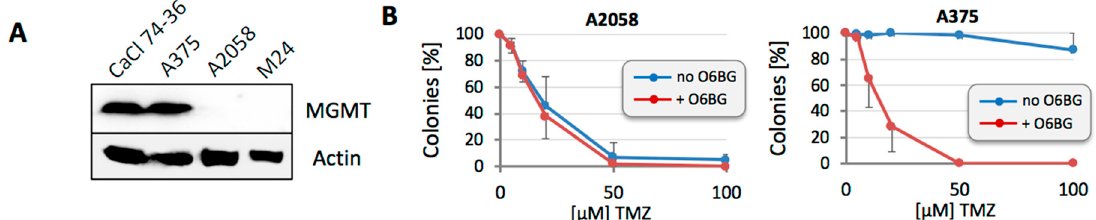
Figure 1. MGMT (O6-methylguanine-DNA methyltransferase) levels and protection from TMZ (temozolomide) toxicity. ( A ) Protein lysates were prepared from four different melanoma cell lines and MGMT protein levels were analyzed by Western blot. Actin was used as the loading control. ( B ) MGMT-negative 2058 cells and MGMT-positive A375 cells were treated with increasing concentrations of TMZ in the absence or presence of 15 µM O6BG. After 12–14 days, emerging colonies were counted. Number of colonies from untreated cells was set at 100% ( n ≥ 5, ±SE).